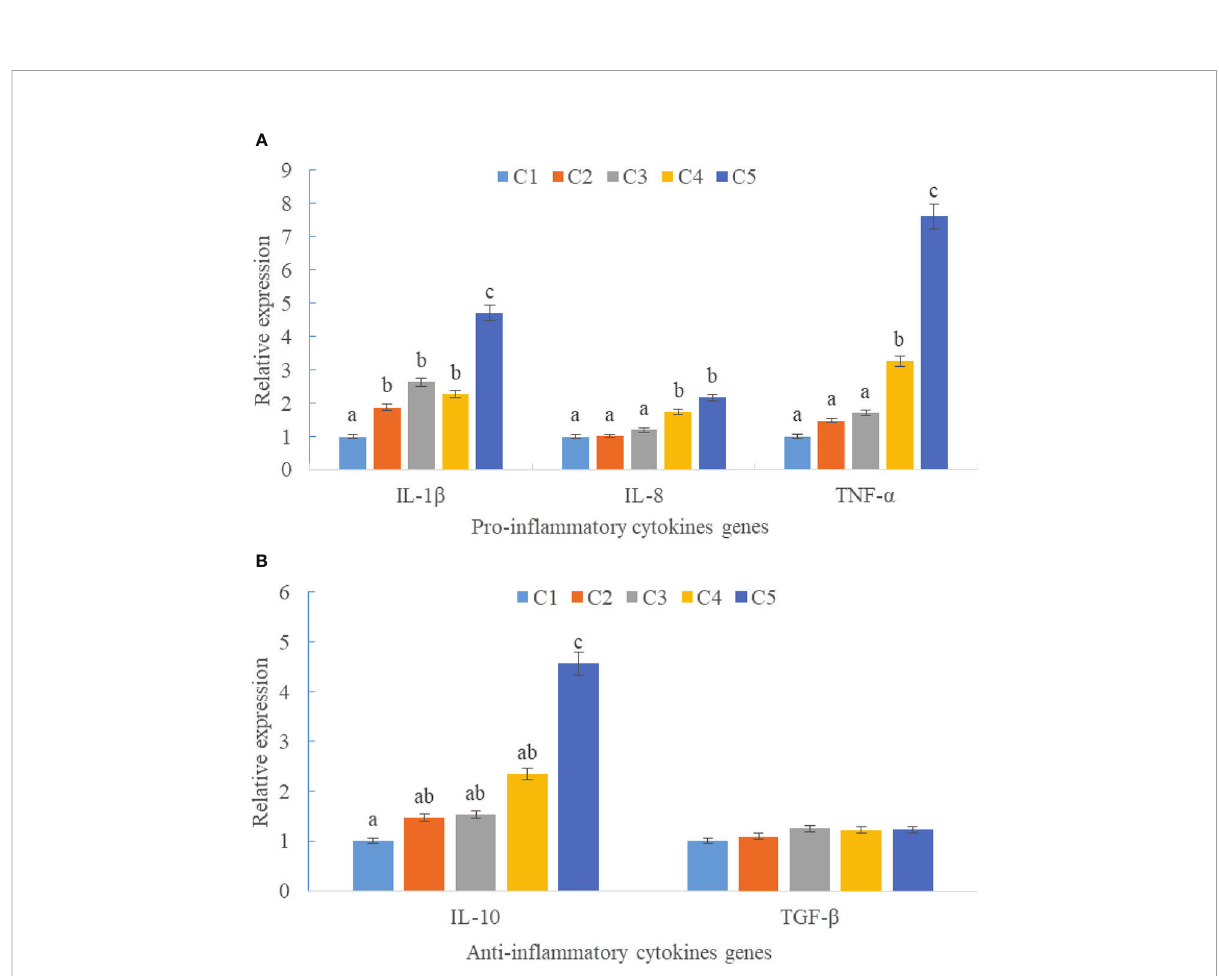
FIGURE 4 Effects of fi shmeal replacement by cottonseed protein concentrate on the mRNA expression levels of in fl ammatory cytokines in intestine of rainbow trout (Mean ± S.E.). (A) Pro-in fl ammatory cytokines genes; (B) Anti-in fl ammatory cytokines genes. Different letters on the bar chart indicate signi fi cant difference ( P < 0.05).